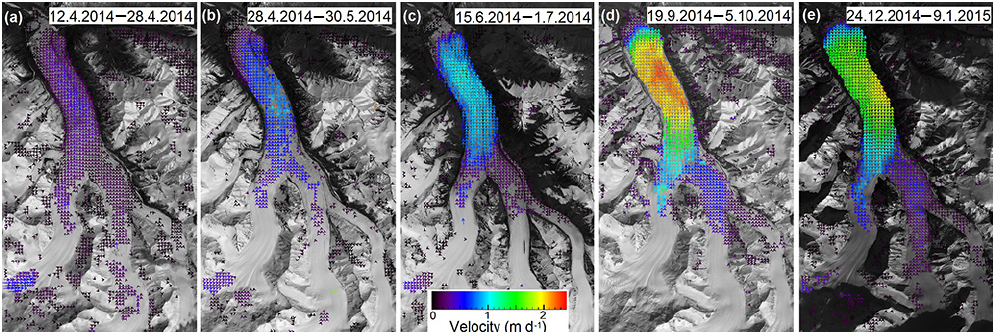
Figure 6. Velocity fields showing the onset and peak of the surge. Panels (a) – (c) show the initial acceleration between April and July 2014; (d) shows the maximum of the surge in September/October followed by deceleration to lower velocities in winter 2014/2015 (e) . Background image from USGS Landsat 8 satellite data.